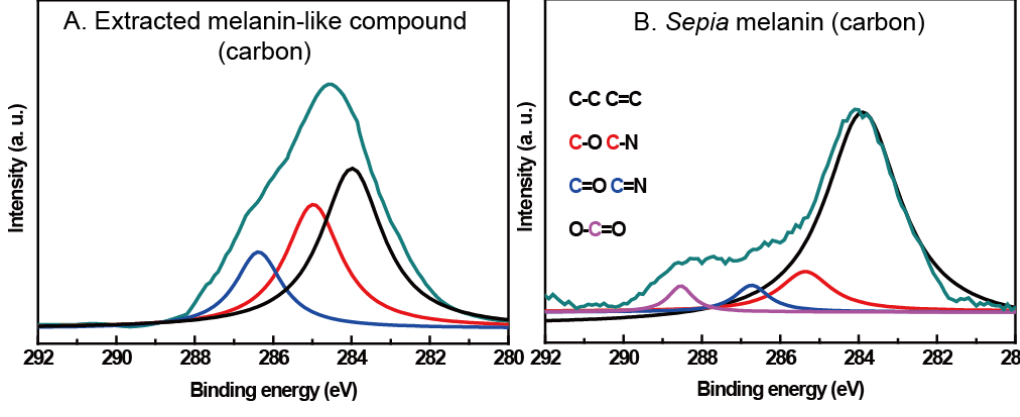
Figure A2. Carbon 1s narrow scans in XPS spectra of extracted melanin-like compound from 10 wt% dopamine containing composite ( A ) and Sepia melanin (control, B